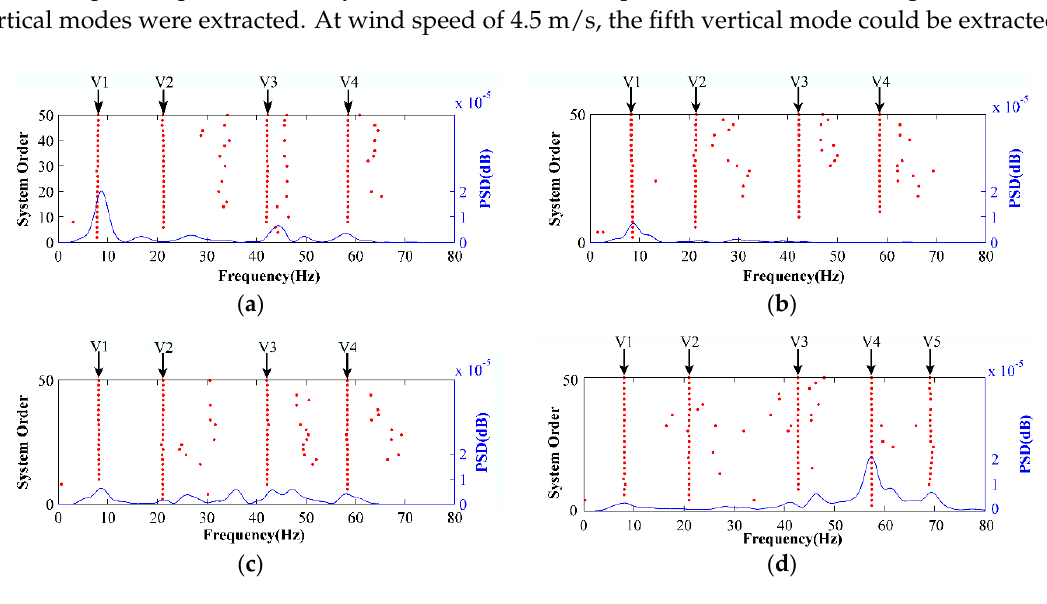
Figure 16. Stability chart and power spectrum density function (PSD) response of stochastic subspace identification (SSI) for modal identification of the conductor at wind velocities of ( a ) 1.5 m/s; ( b ) 2.2 m/s; ( c ) 3.7 m/s; ( d ) 4.5 m/s.